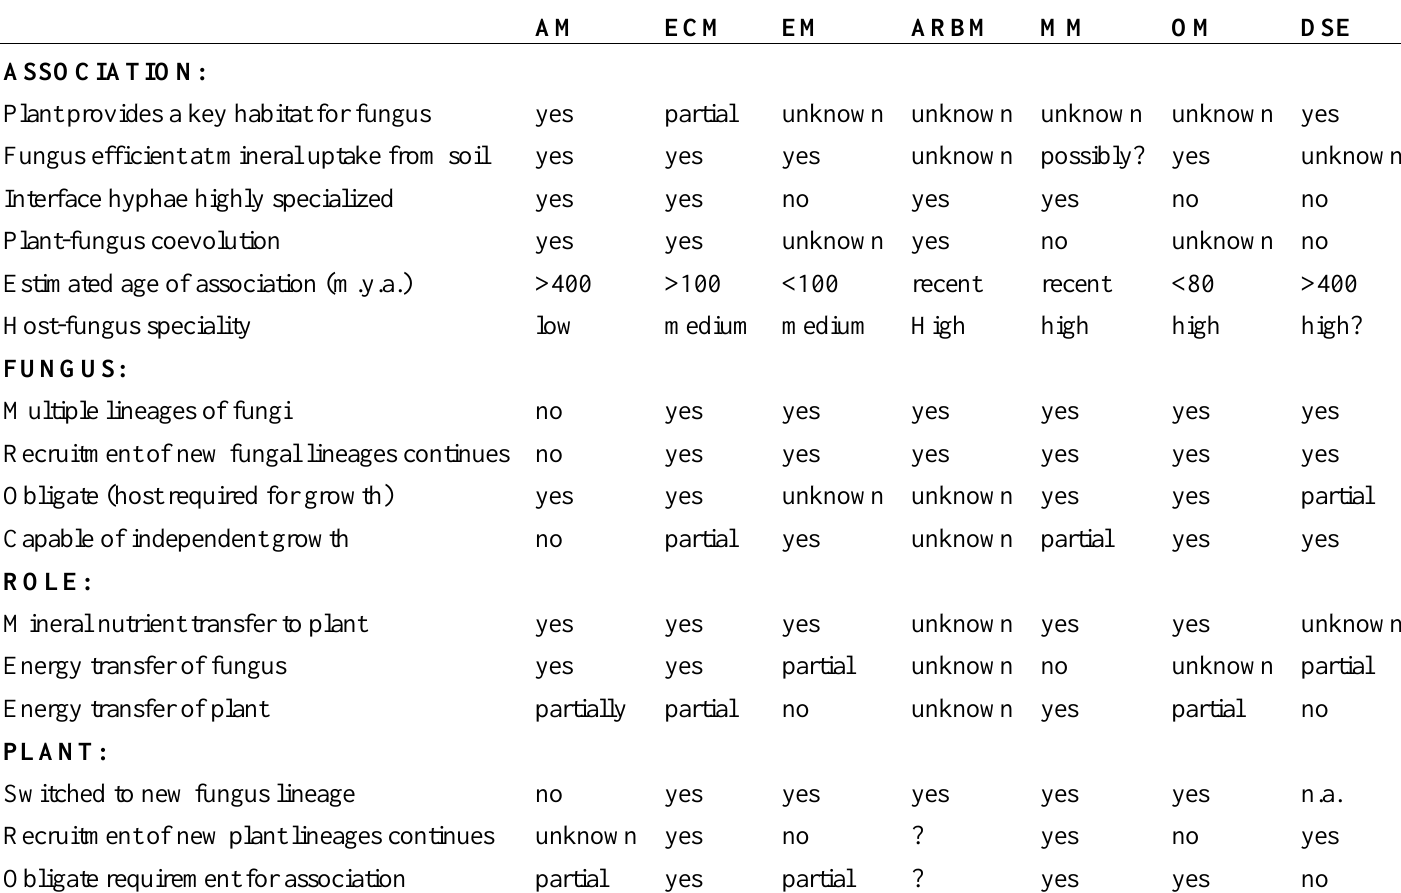
Table 4. Functional diversity of mycorrhizas and DSE (adapted from